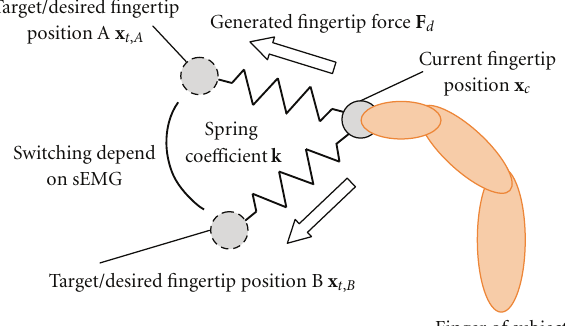
Figure 4: Virtual spring model. This method needs current and target fingertip positions. The current position can be obtained from the haptic device. It is necessary to measure the target positions beforehand or to calculate them with solving